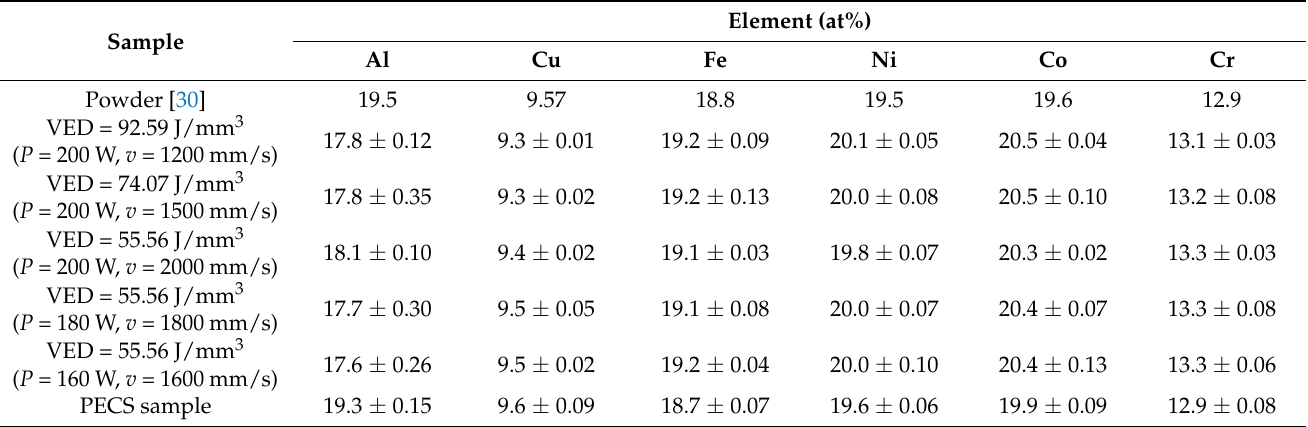
Table 3. Chemical composition of as-built specimens, a reference PECS sample, and the starting powder.